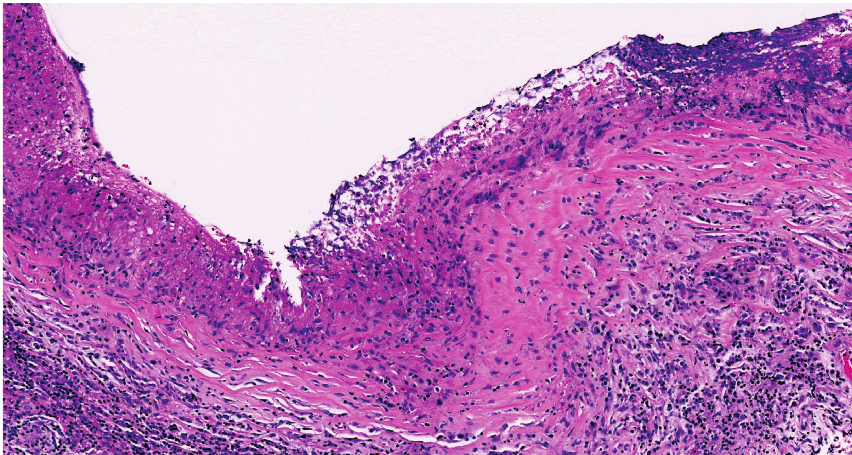
Figure 2: Histologic features of the resected left temporal lobe lesion. Fibrous cyst wall lined by aggregates of epithelioid histiocytes and multinucleated giant cells, along with necrosis and a mixed inflammatory infiltrate in the adjacent area (H&E, original magnification 200x).